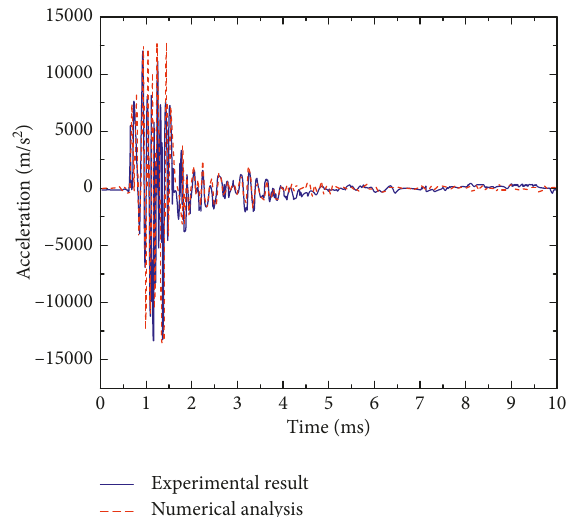
Figure 10: Acceleration-time history curve of #3 acceleration sensor.